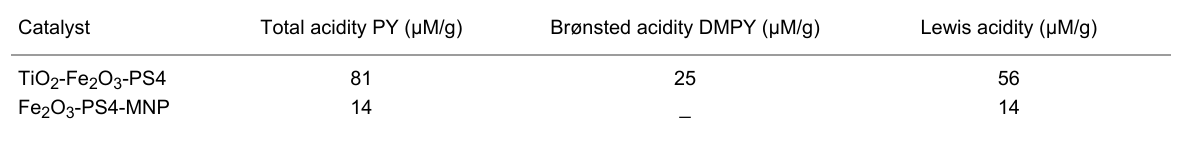
Table 2: Surface acidity of iron oxide/polysaccharide nanohybrids. Catalyst